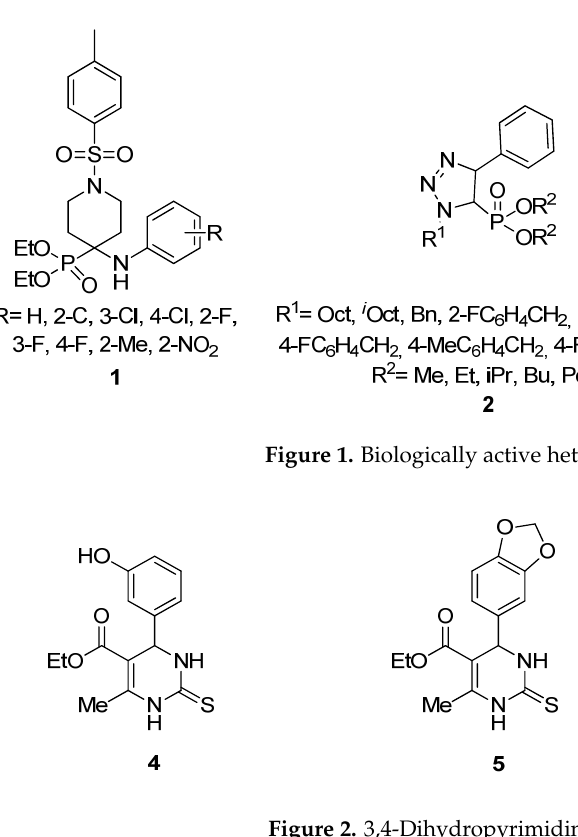
Figure 2. 3,4 ‐ Dihydropyrimidin ‐ 2(1 H ) ‐ one derivatives. Figure 2. 3,4-Dihydropyrimidin-2(1 H )-one